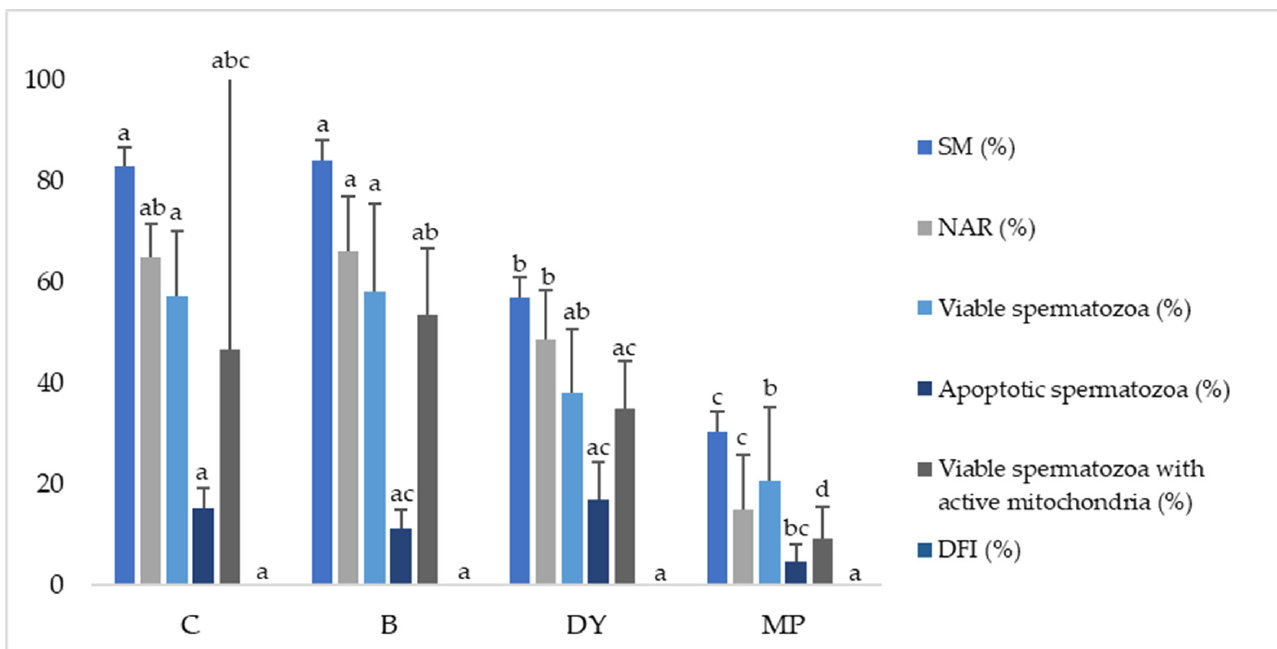
Figure 4. Effect of freezing techniques on post-thaw sperm quality in Iberian red deer epididymal spermatozoa. C (control—liquid nitrogen vapor in a tank), B (box—polystyrene box with liquid nitrogen inside), DY (dry ice—polystyrene box with dry ice inside), and MP (metallic plate—solid metallic plate floating on the surface of liquid nitrogen). Data represented as mean ± SEM. SM— sperm motility (%); NAR—acrosome integrity (%); viable (nonapoptotic) spermatozoa (%); apoptotic spermatozoa (%); viable spermatozoa with active mitochondria (%); DFI—DNA fragmentation index (%). Different letters indicate significant differences between freezing methods ( p ≤ 0.05). Table 3. Effects of different freezing techniques on kinematics parameters of Iberian red deer epididymal spermatozoa. C (control—liquid nitrogen vapor in a tank), B (box—polystyrene box with liquid nitrogen inside), DY (dry ice—polystyrene box with dry ice inside), and MP (metallic plate—solid metallic plate floating on the surface of liquid nitrogen). Data represented as mean ± SEM. VCL— curvilinear velocity ( µ m/seg); VSL—rectilinear velocity ( µ m/seg); VAP—velocity for the corrected trajectory ( µ m/seg); LIN—linearity (%); ALH—lateral head displacement ( µ m). Different letters within columns indicate significant differences ( p ≤ 0.05).